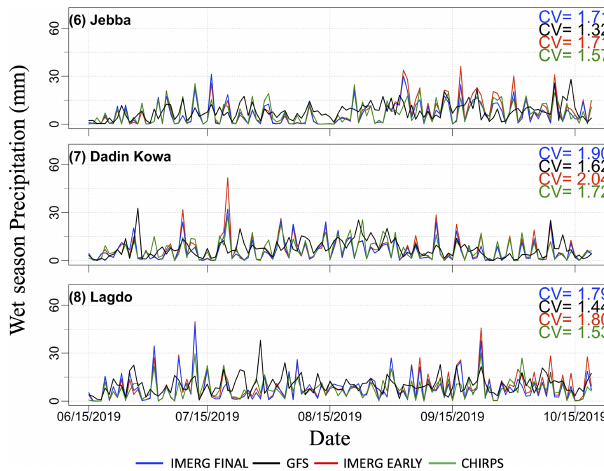
Figure 6. Same as Fig. 5 but for the remaining three